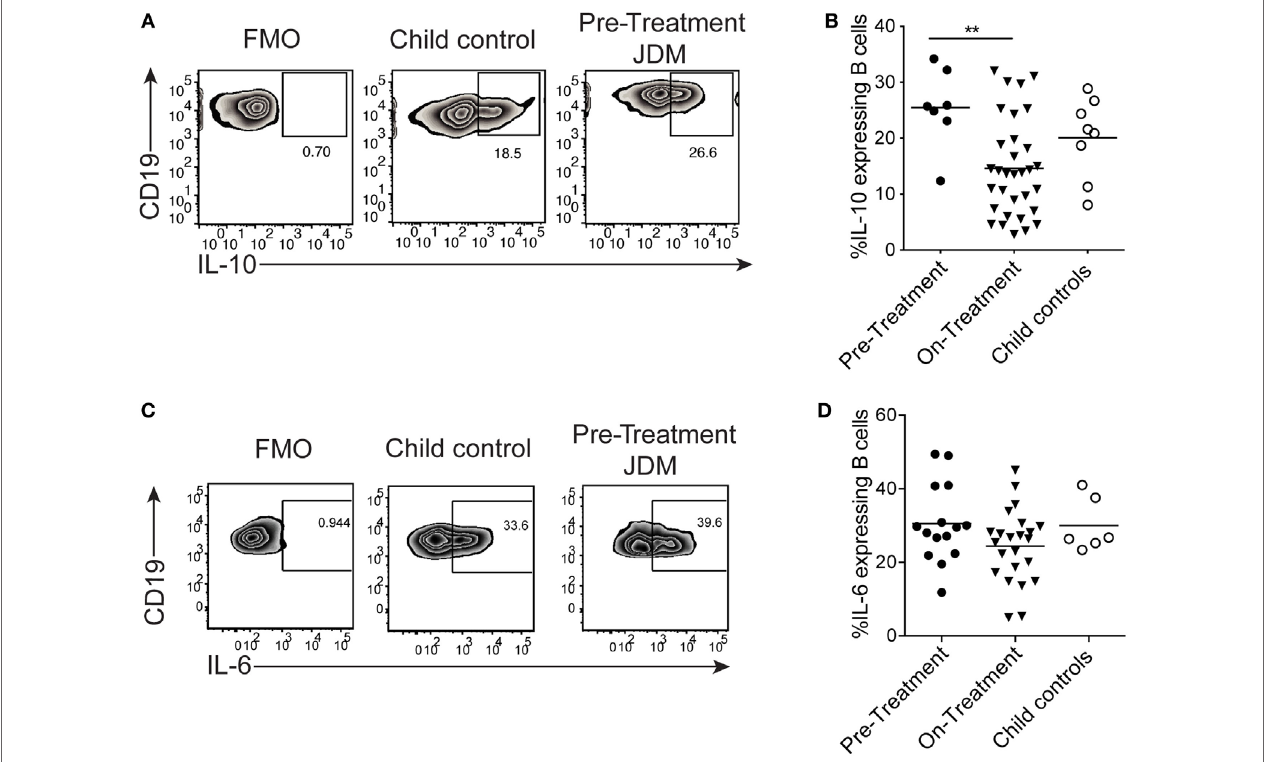
FigUre 5 | B cells from juvenile dermatomyositis (JDM) patients are able to express IL-10 upon CD40 stimulation. Peripheral blood mononuclear cells (PBMC) were stimulated with CD40L-expressing Chinese Hamster Ovary cells for 72 h, and B cell IL-10 expression was analyzed by flow cytometry, following addition of PMA, Ionomycin, and Brefeldin A for the last 4 h of culture. (a) Representative flow cytometry plots of B cell IL-10 expression are shown for JDM pre-treatment, on-treatment, and child controls. (B) The frequency of IL-10-expressing B cells after 72 h culture with CD40L stimulation is summarized for each of the groups. PBMC were stimulated for 4 h with PMA/Ionomycin (c) Representative flow cytometry plots of total B cell IL-6 staining are shown (left–right: FMO, child control, and JDM pre-treatment). (D) IL-6 expression by B cells are summarized for JDM subgroups and child controls. For panels (B,D) , lines represent mean values (* p < 0.05 and ** p <